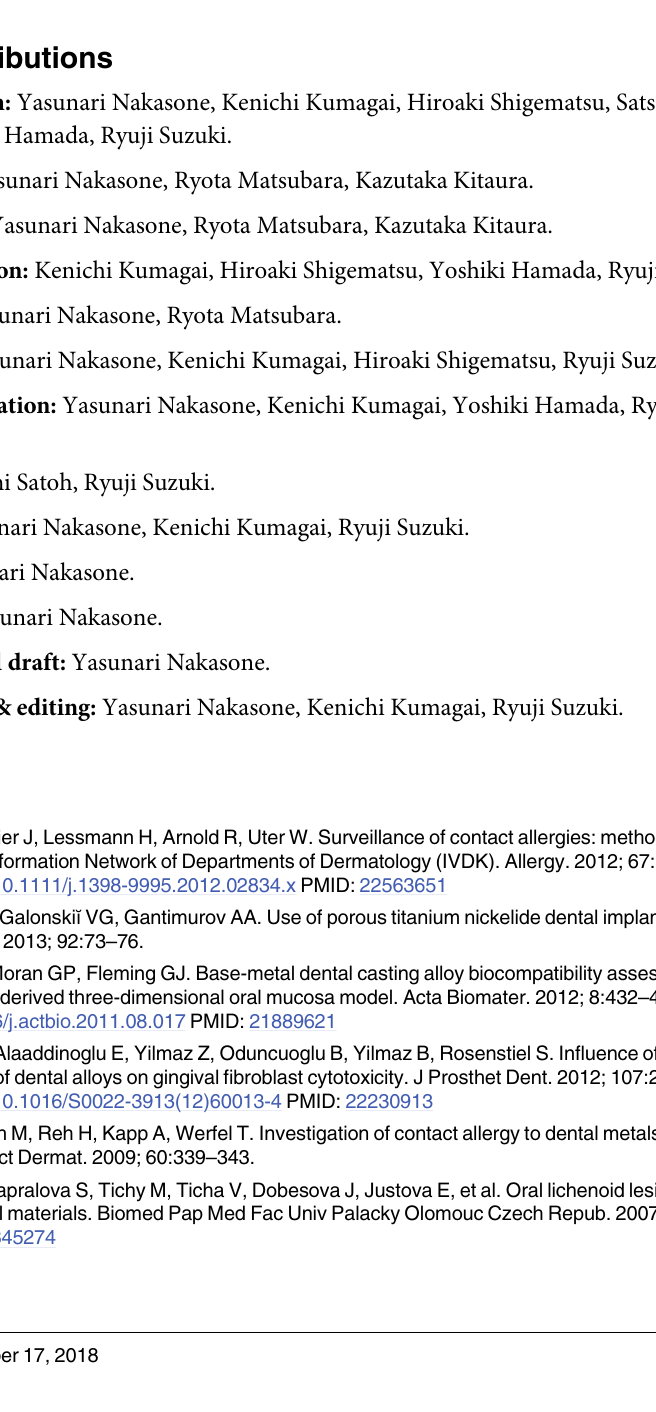
S2 Fig. Top 40 ranking read numbers of TRB clonotypes in ICD and ACD mice. There was no shared TRB clone between the oral mucosa and cervical lymph nodes in ICM and ACM mice.